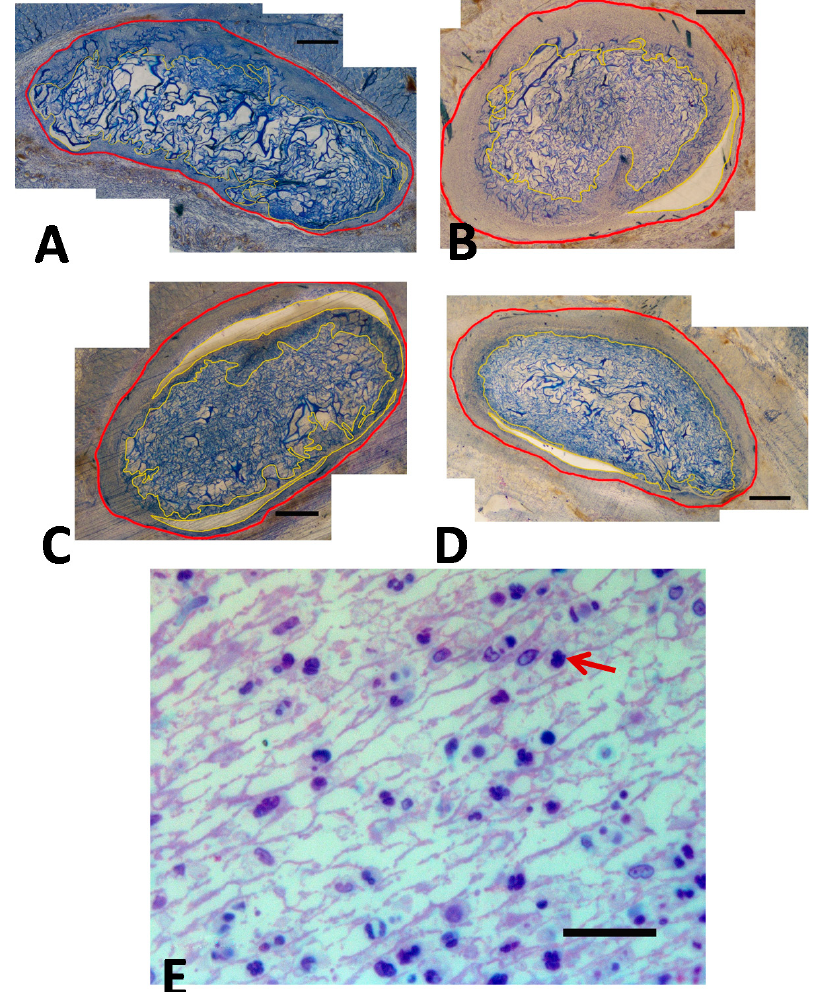
Figure 1. Microscopic findings following subcutaneous implantation of: ( A ) dry Absorbed Collagen Sponge (ACS); ( B ) dry bone morphogenetic protein-2 (BMP-2)/ACS; ( C ) wet ACS; ( D ) wet ACS/BMP-2; ( E ) high magnification of inflamed zone. Red arrow: macrophage. The inflammatory zone was delineated by two different lines: the outer border in red, the inner border in yellow. Bar = 500 µm (in A – D ). The upper side is skin side and the lower side is lumber body side. Numerous macrophages were identified in the highly vascularized inflamed zone (cf. 1E, bar = 20 µm).